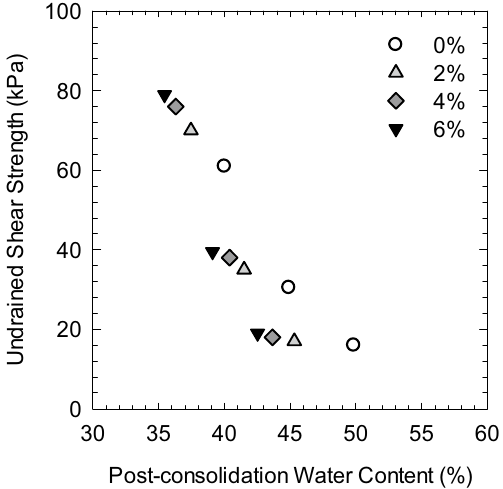
Figure 8. Undrained shear strength versus water content of soft marine clay at different salinities.